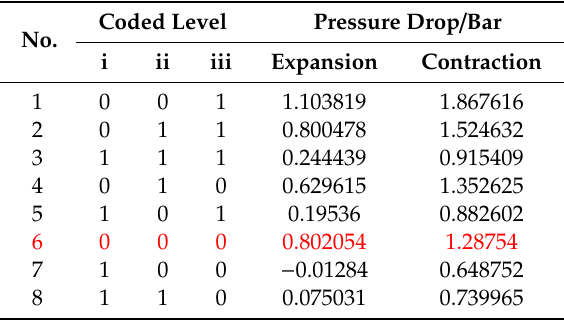
Figure 18. Lofted features applied in three different regions. Table 6. Results of full factorial design for L ‐ i, ‐ ii, and ‐ iii.